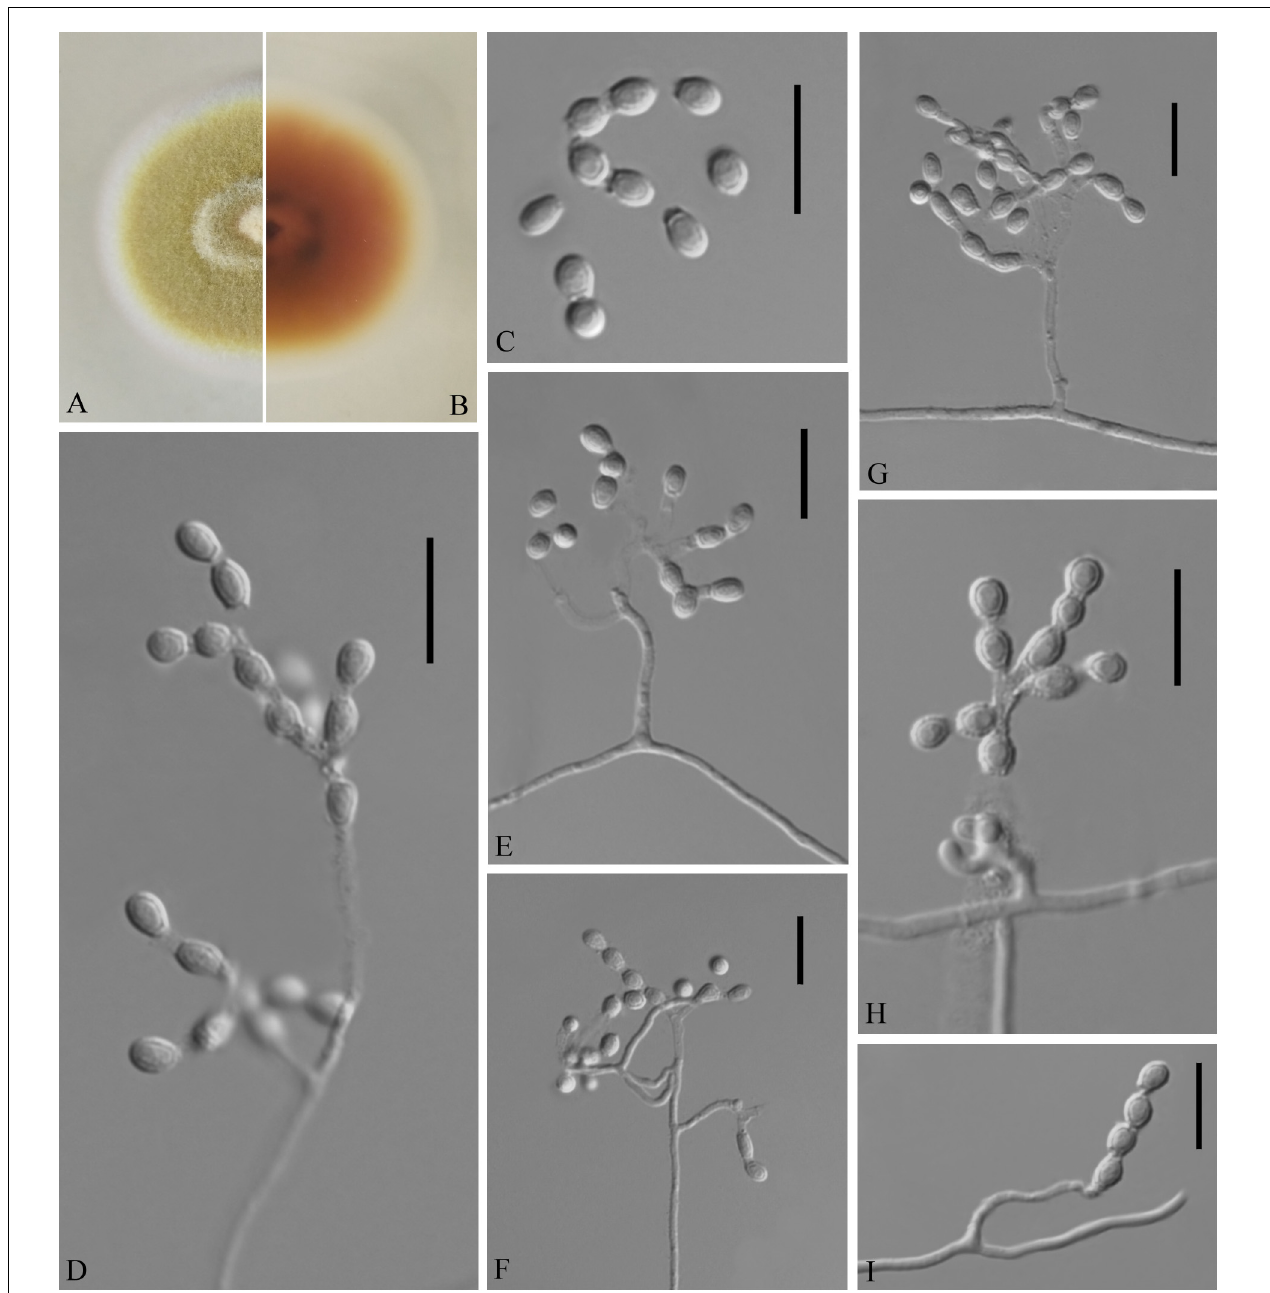
FIGURE 3 | Geomyces obovatus [from ex-holotype China General Microbiological Culture Collection Center (CGMCC) 3.18491]. (A,B) The front and reverse of a G. obovatus colony on potato dextrose agar (PDA) after 14 days at 25 ◦ C. (C–I) Conidiophores and conidia. Scale bars = 10 µ